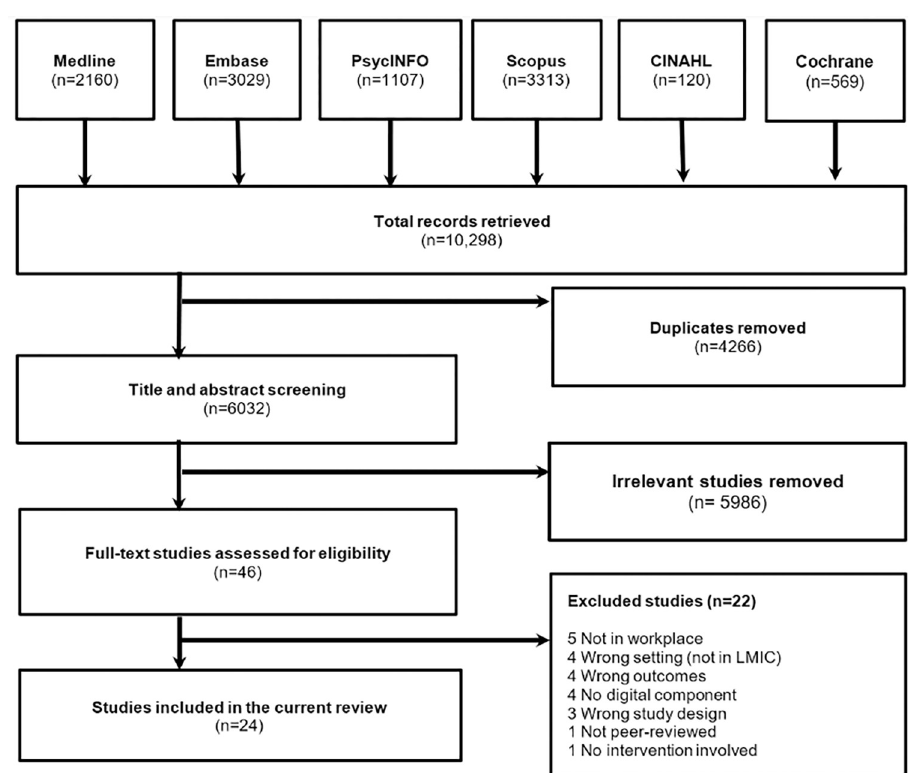
Fig 1. PRISMA flow chart of study selection process including reasons for excluded